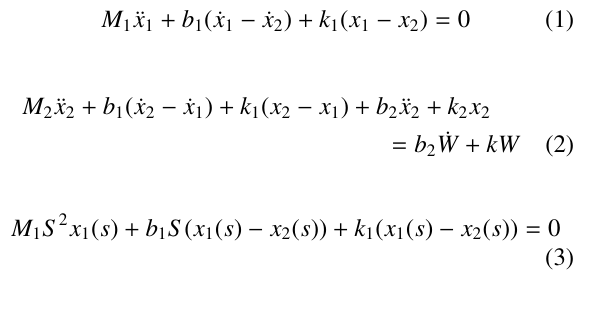
The equation of motion would be as follows if